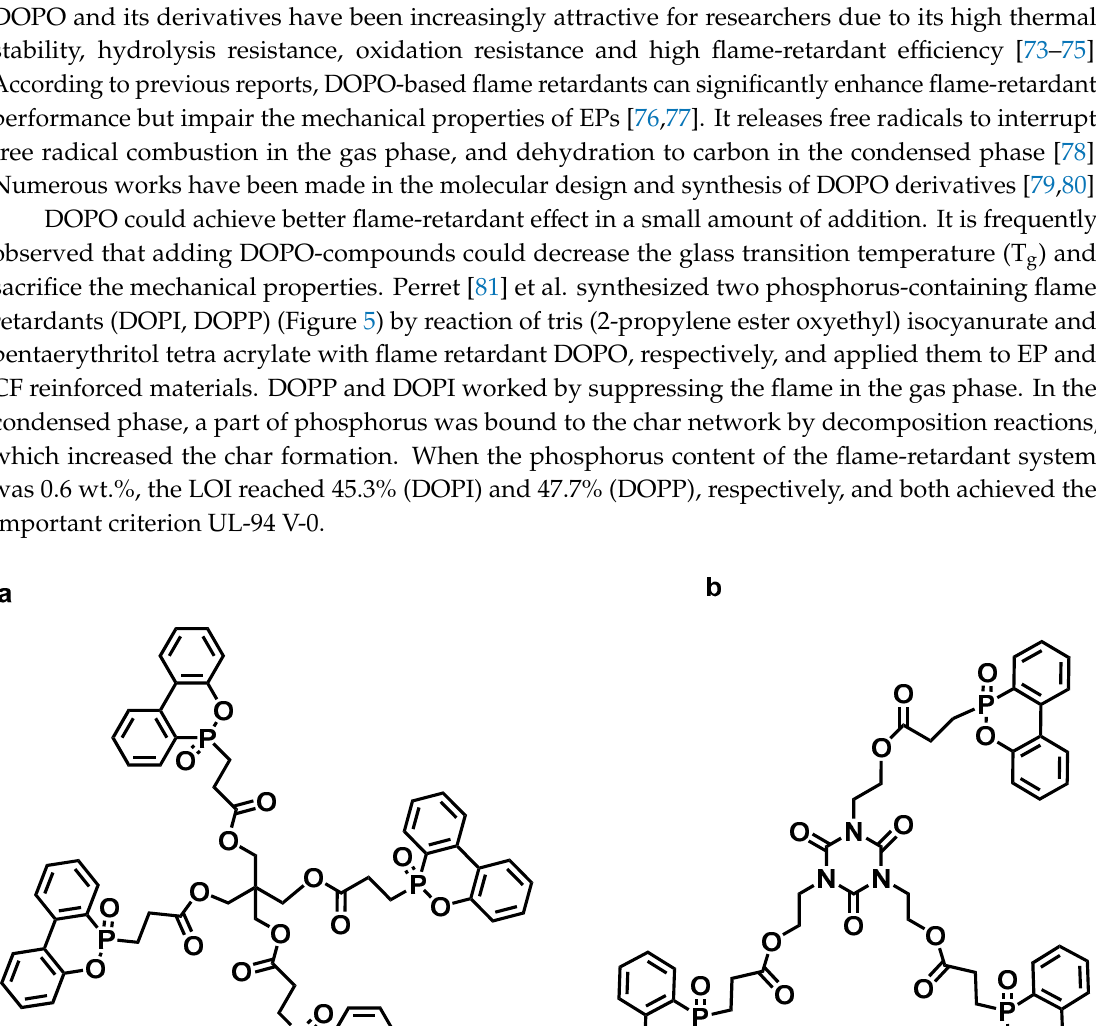
Figure 6. Synthesis route of ABD. Readapted with permission from Ref. [51], Copyright 2019, Elsevier Ltd. T. Wang [82] et al. synthesized epoxy composites with DOPO and 1,10-(methylenedi-4,1- phenylene) bismaleimide (BDM). The test results indicated that BDM and DOPO have a synergistic effect on the flame retardancy of EPs. With the synergistic effect of BDM and DOPO, the av-HRR, pk- HRR and THR was reduced as the load of BDM increased but simultaneously led to an increase in LOI. Moreover, epoxy composites reached the UL-94 V-0 grade, and the carbon residue increased considerably at high temperature. A DOPO-based tetrazole derivative (ATZ) was synthesized (Figure 7) and integrated into the EP matrix as co-curing agent [83]. The addition of ATZ significantly improved the flame retardancy of EPs. The LOI value of 33.7% and UL-94 V-0 rating were obtained when the content of ATZ was as low as 6 wt.%. Significant reduction in PHRR and THR compared to neat EP. Furthermore, ATZ could act in both gas and condensed phases. In the gas phase, flame retardance was mainly achieved by the quenching effect of phosphorus radicals and the suppression of flame by inert gas. The flame